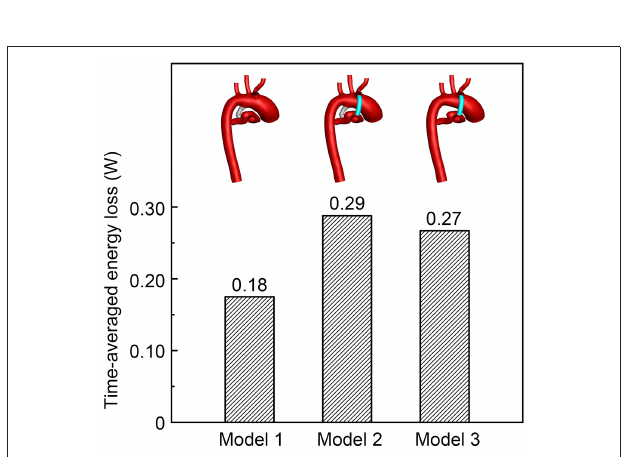
FIGURE 8 | Time-averaged energy loss of a cardiac cycle.